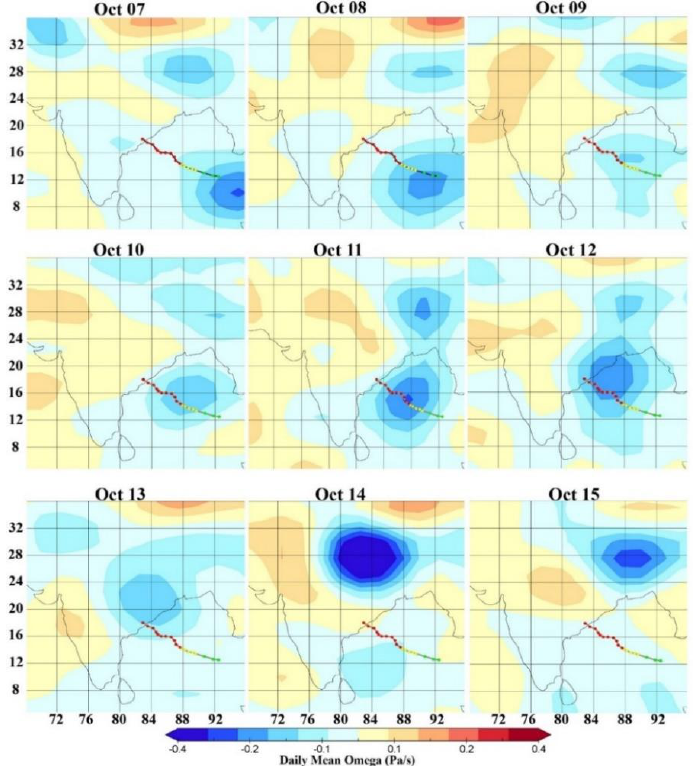
Figure 6. Spatio-temporal variations of omega during 7–15 October 2014 at 700 hPa pressure level along the track of cyclone Hudhud.